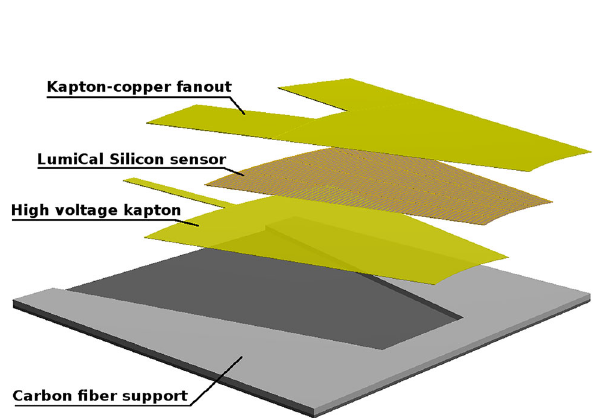
shown) between components is within 10–15 µ m. The total thickness is 650 µ